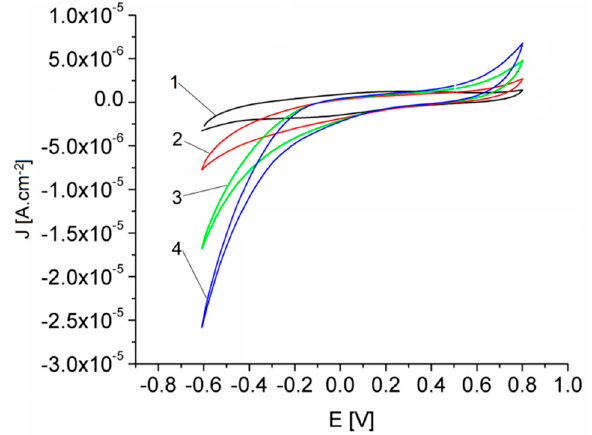
Figure 9. Cyclic voltammograms obtained in MES buffer solution, pH = 5.6 for the Pt-Porf-GCE using different concentrations of H 2 O 2 [mM]: 9.65 (1); 19.3 (2); 28.95 (3); 48.25 (4). 50 mV/s, 25 °C.